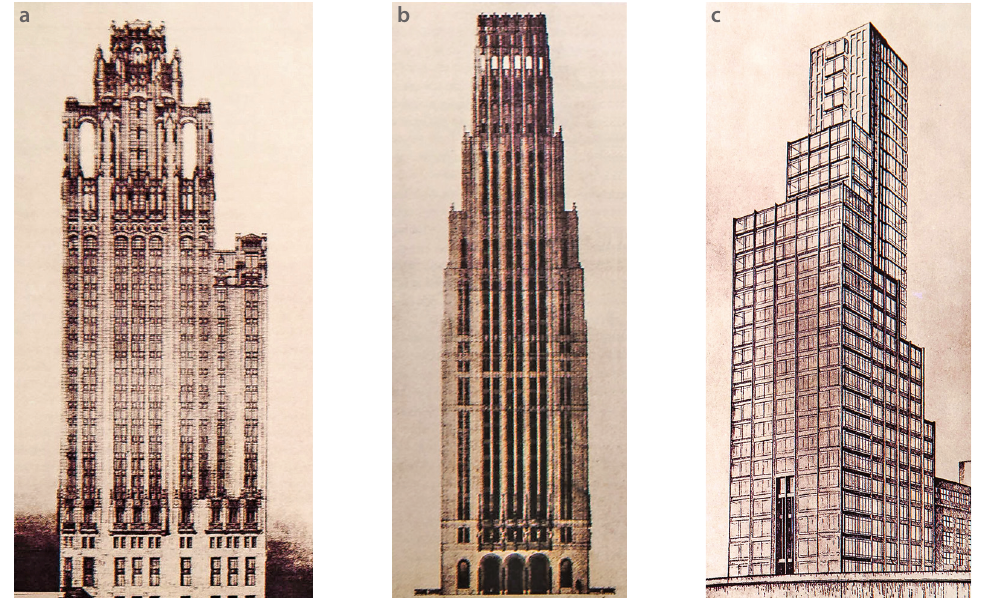
fig. 3. Competition for the Chicago Tribune Tower, 1922: a – design project by raymond M. Hood and john Mead (uSa), the 1 st place; b – design project by Eliel Saarinen (finland), the 2 nd place; and c – design project by Walter Gropius and adolf